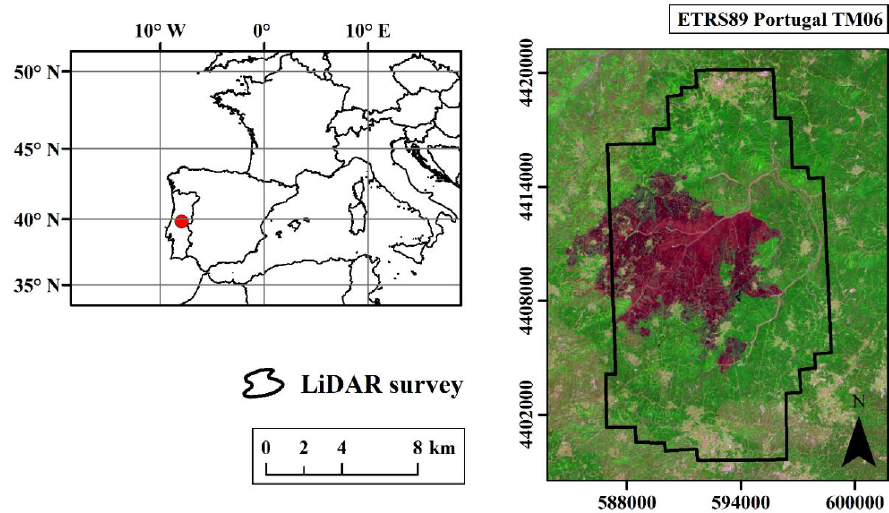
Figure 1. Location of the study site within the LiDAR flight site of the áGiLTerFoRus project in central Portugal. The background image is a Sentinel-2 false color composite (R = band 12; G = band 8A; B = band 4) that allows us to highlight the wildfire scar that occurred one month after the LiDAR survey.